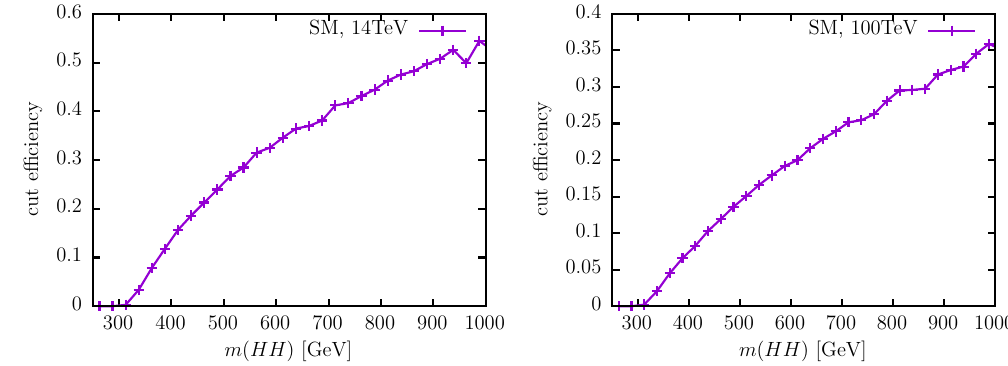
Figure 17 . Di(cid:11)erential cut e(cid:14)ciency for SM double-Higgs signal from the b (cid:22) b(cid:13)(cid:13) signature, at parton